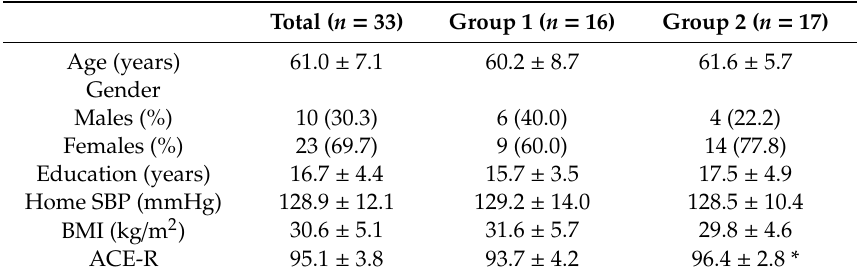
Table 1. The demographic and clinical characteristics of the study sample at baseline, according to the first dietary intervention 1